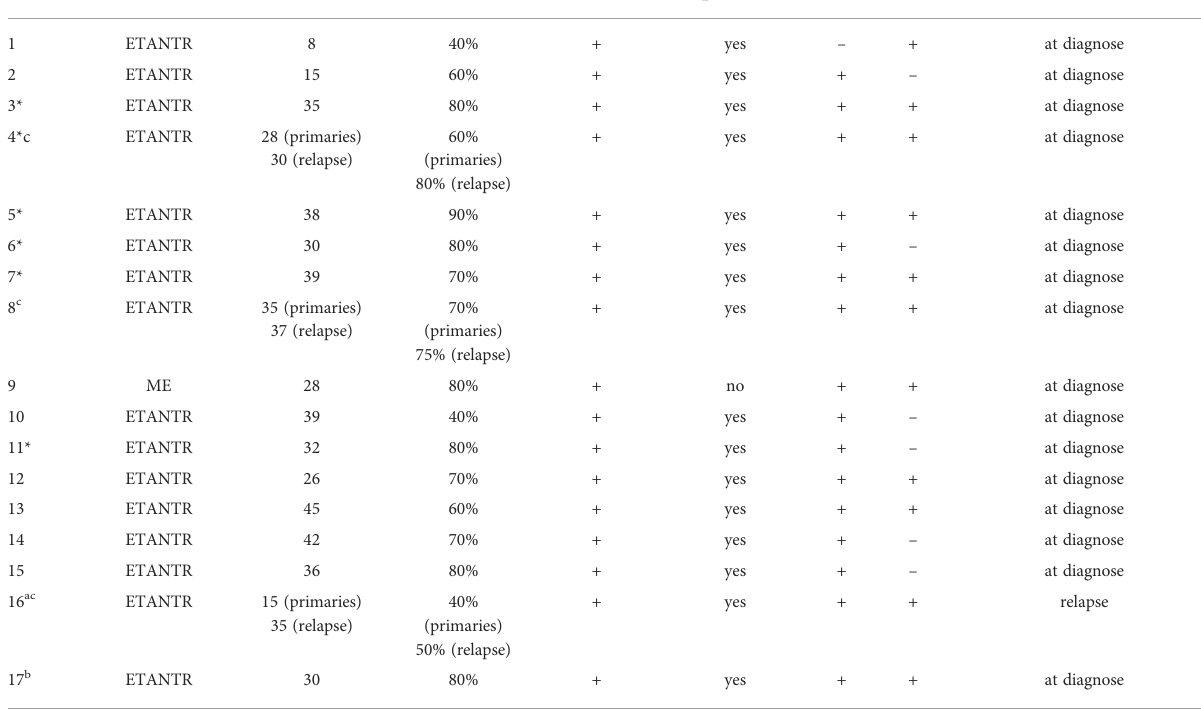
TABLE 2 Histopathologic features of 17 patients of ETMRs. Number Morphology Mitoses/10 HPFs Ki67 index LIN28A IHC